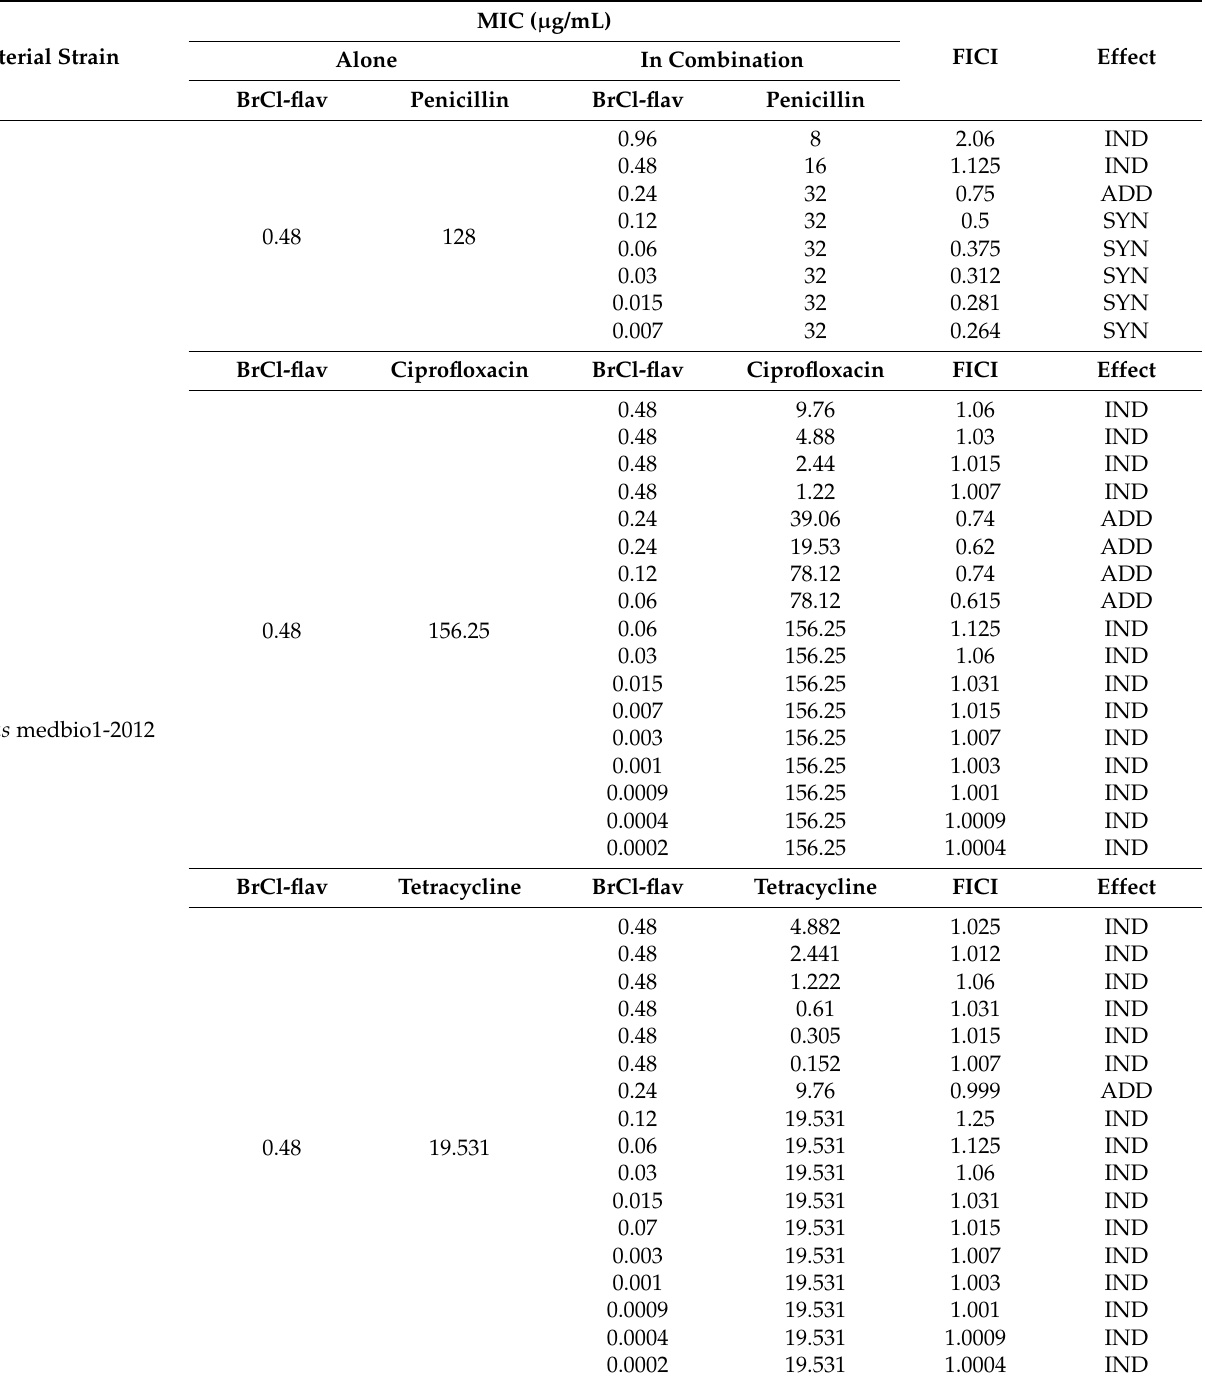
Table 2. Fractional inhibitory concentration indices (FICIs) of BrCl-flav and antibiotics against a clinical isolate of